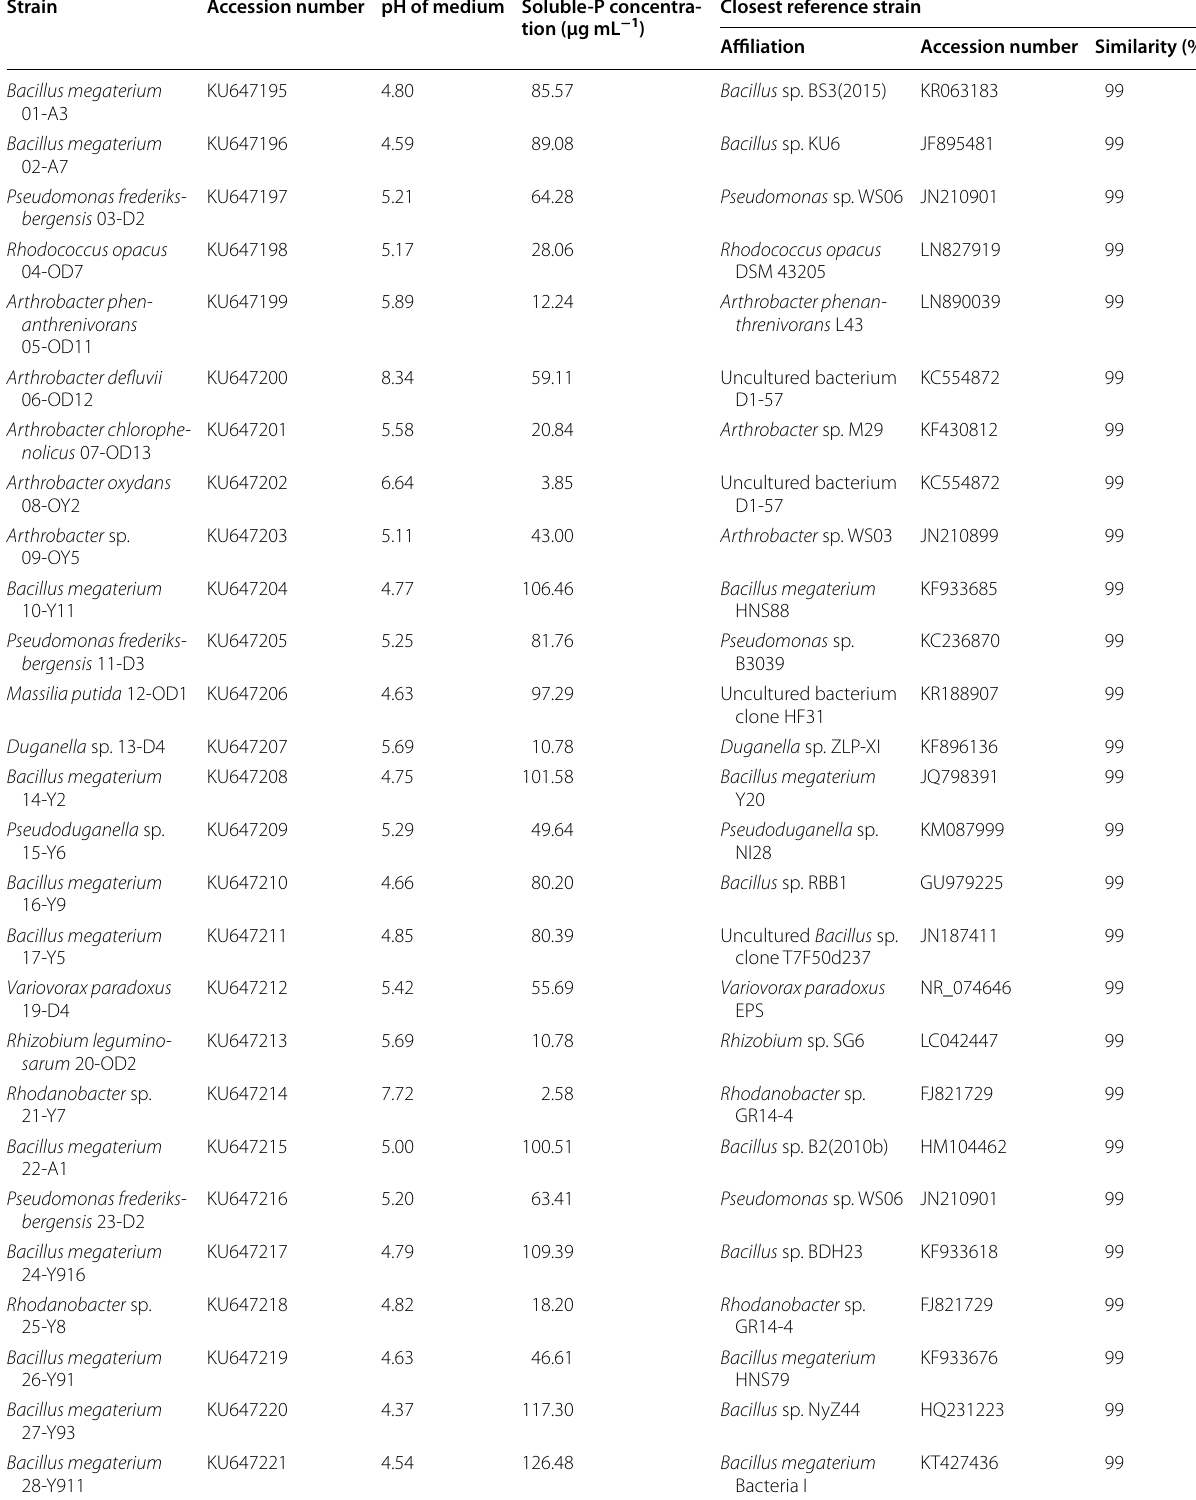
Table 2 Accession numbers, medium pH and soluble-P concentrations of the iPSB strains after incubation for 72 h, and the closest reference